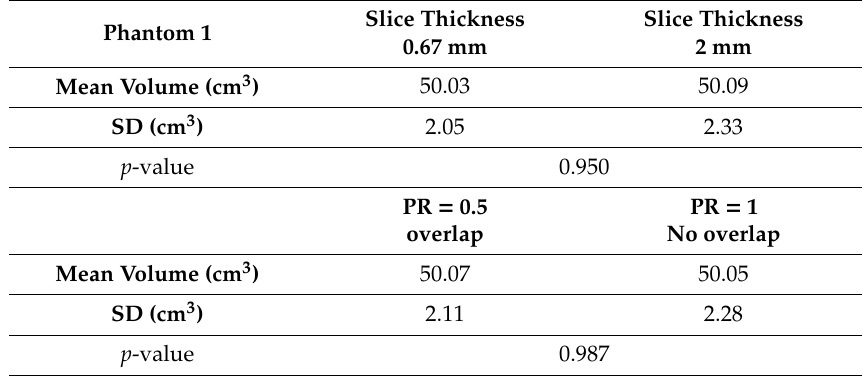
Table 2. Results from preliminary assessment of EVAR-eaSE accuracy using radiological phantom 1.